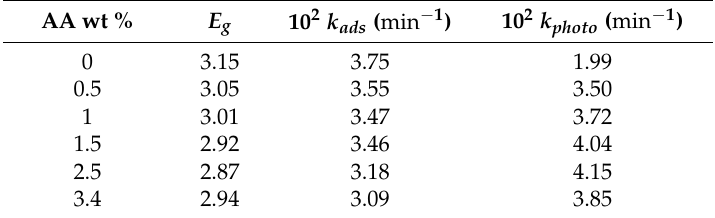
Table 2. E g , k ads and k photo values for [PP@AA-TiO 2 ] A containing different AA wt